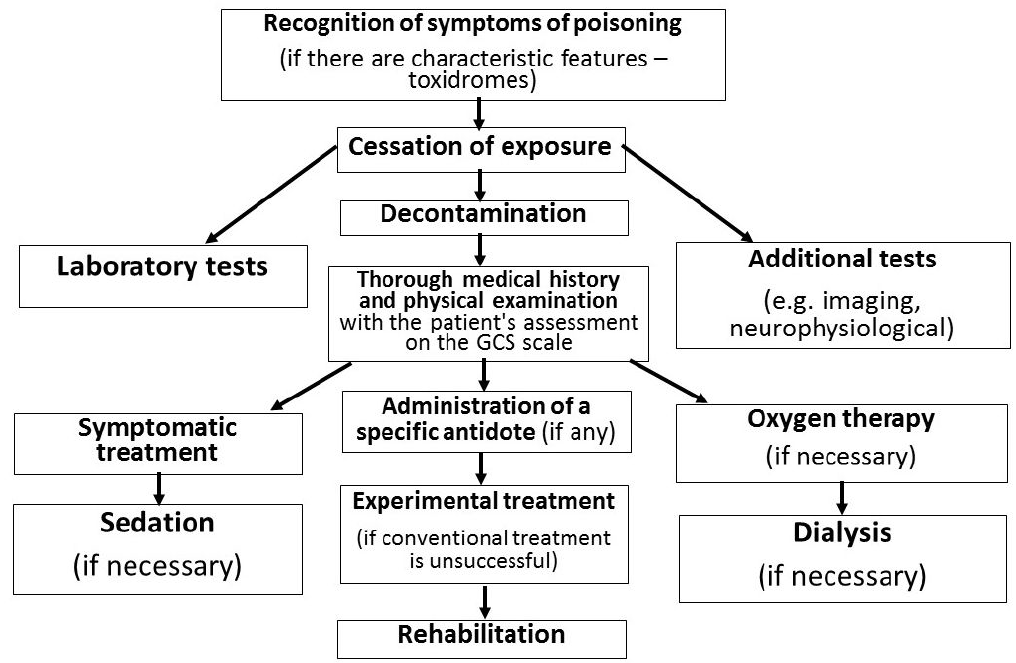
Figure 8. Algorithm for dealing with suspected criminal poisoning.